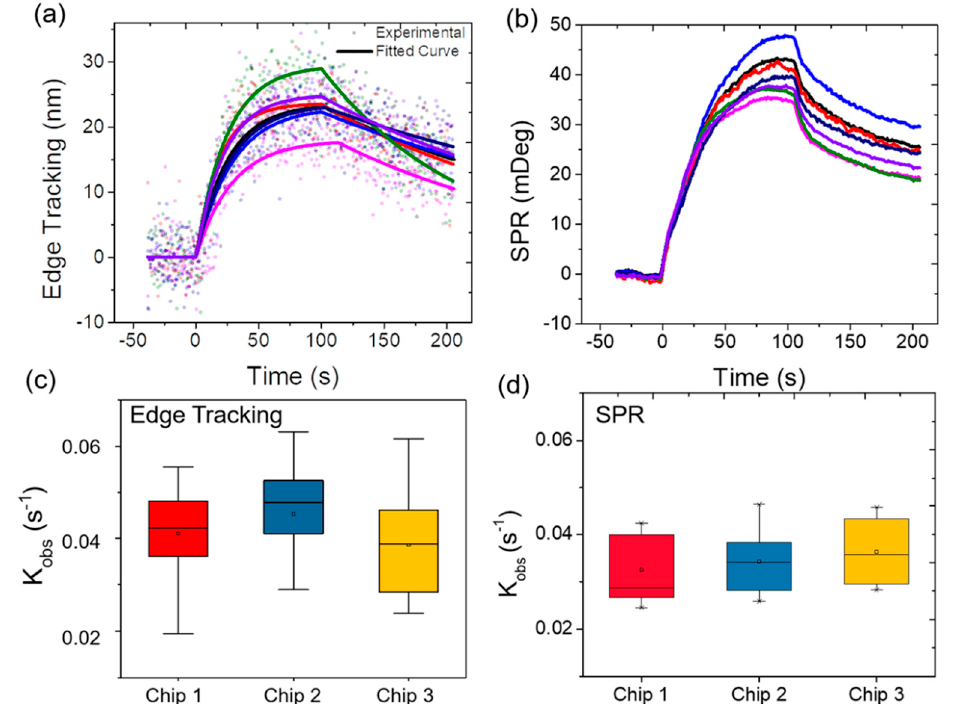
Figure 3. Cell-to-cell and chip-to-chip variability. Binding response curves from different cells on the same chip were recorded simultaneously by ( a ) edge tracking and ( b ) SPR (WGA concentration 20 µg/mL). Dots and solid lines represent experimental data and first-order kinetic fitted curves. Signals from the same cells are shown in the same color. Box and whisker plots of the observed kinetics constant measured by simultaneous ( c ) edge tracking and ( d ) SPR from 3 different chips. Each chip had at least a dozen cells, and all cells were exposed to 100 µg/mL WGA. Table 1. Measured WGA binding kinetic constants with edge tracking and SPR.